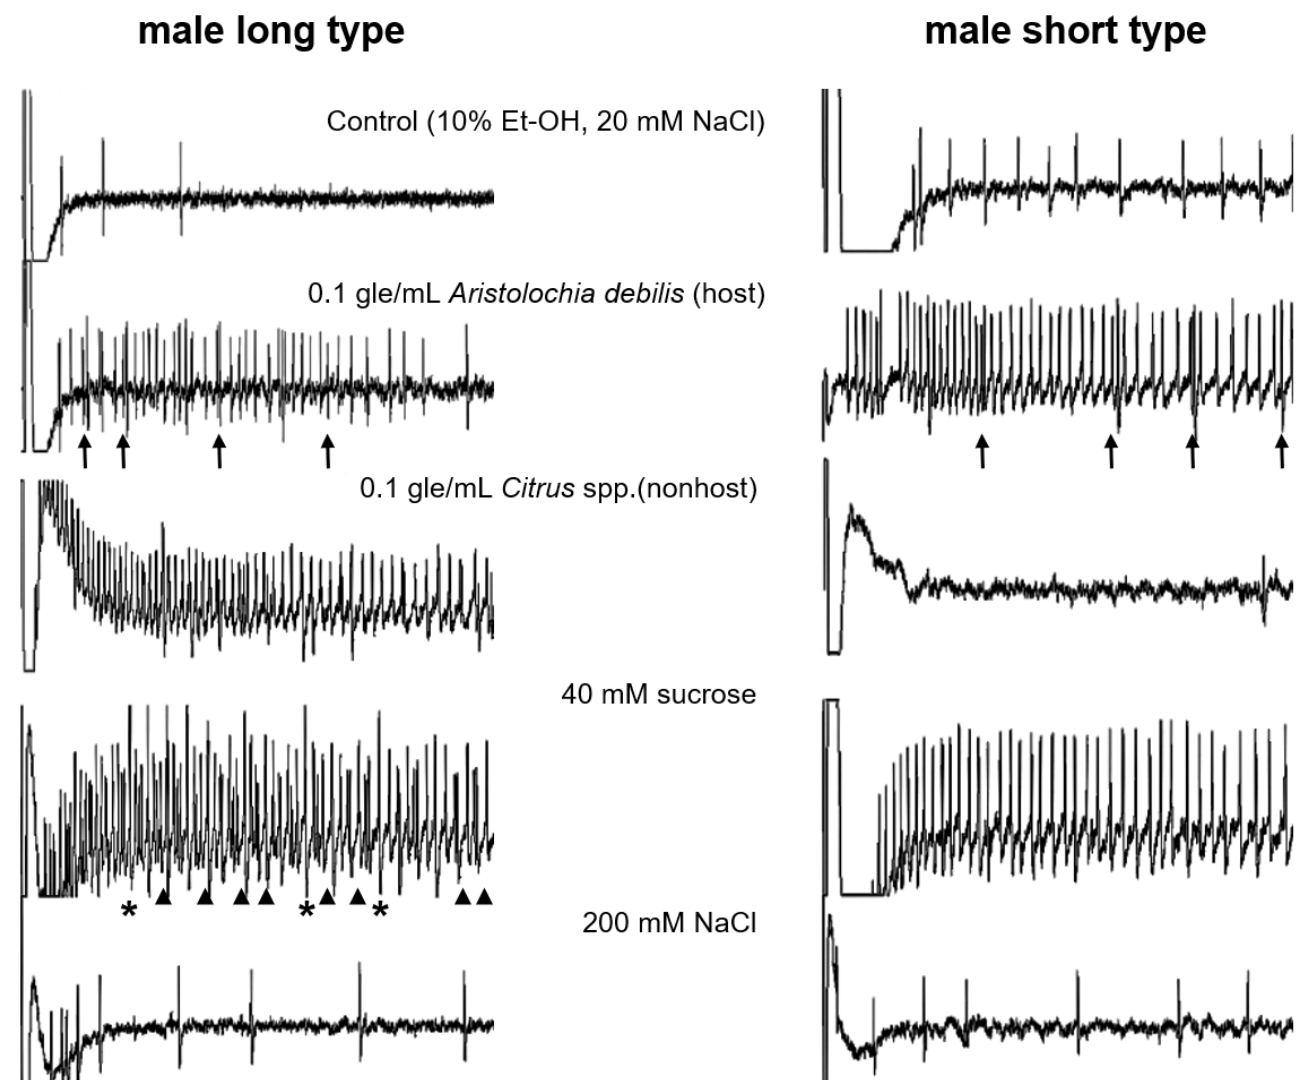
Figure 3. Electrophysiological responses to stimulants from male sensilla. Individual responses covered 0.5 s after stimulus onset. Stimulation with extracts of host plants Aristolochia debilis caused one cell to fire at a constant rate and another (indicated by arrows) to fire irregularly and less frequently in the long ‐ and short ‐ type sensilla. Stimulation with sucrose caused one taste cell to fire at a constant rate and another (indicated by arrowheads) to fire irregularly and less frequently in the long ‐ type sensilla. Asterisks indicate doublets of two spikes from two different cells. “gle/mL” indicates gram leaf equivalent in 1 mL of control